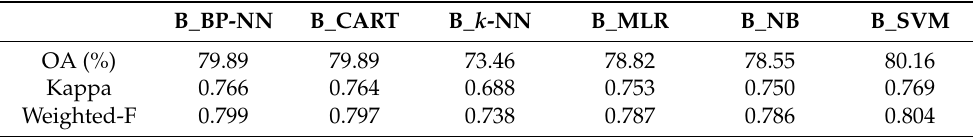
Table 4. Overall accuracies, kappa values, and weighted-average F-scores of the bagging